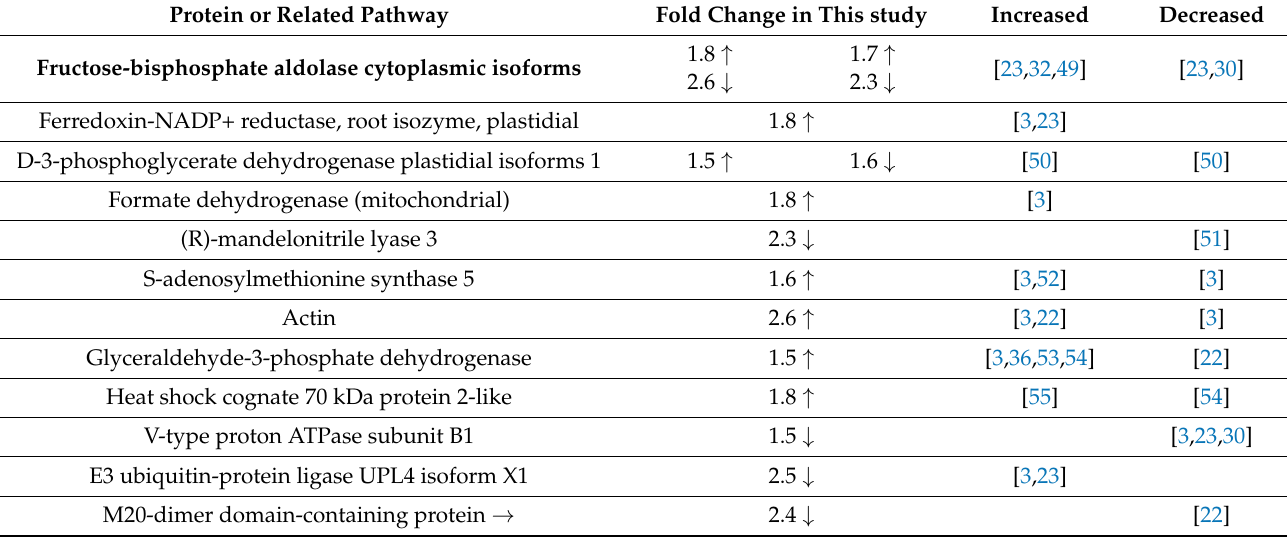
Table A1. Some references in the literature concerning salt-responsive proteins in roots. Isoenzymes can exhibit different fold changes. ↑ upregulated and ↓ downregulated